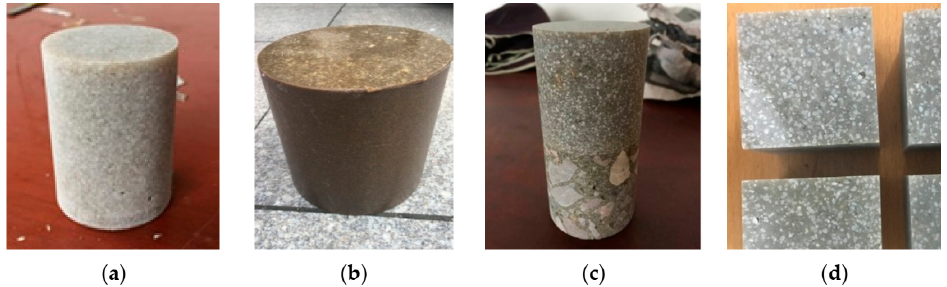
Figure 1. Test specimens of the SN-modified underwater composite-repairing material: ( a ) deforma- bility; ( b ) impermeability; ( c ) bond strength; ( d ) compressive strength tests.